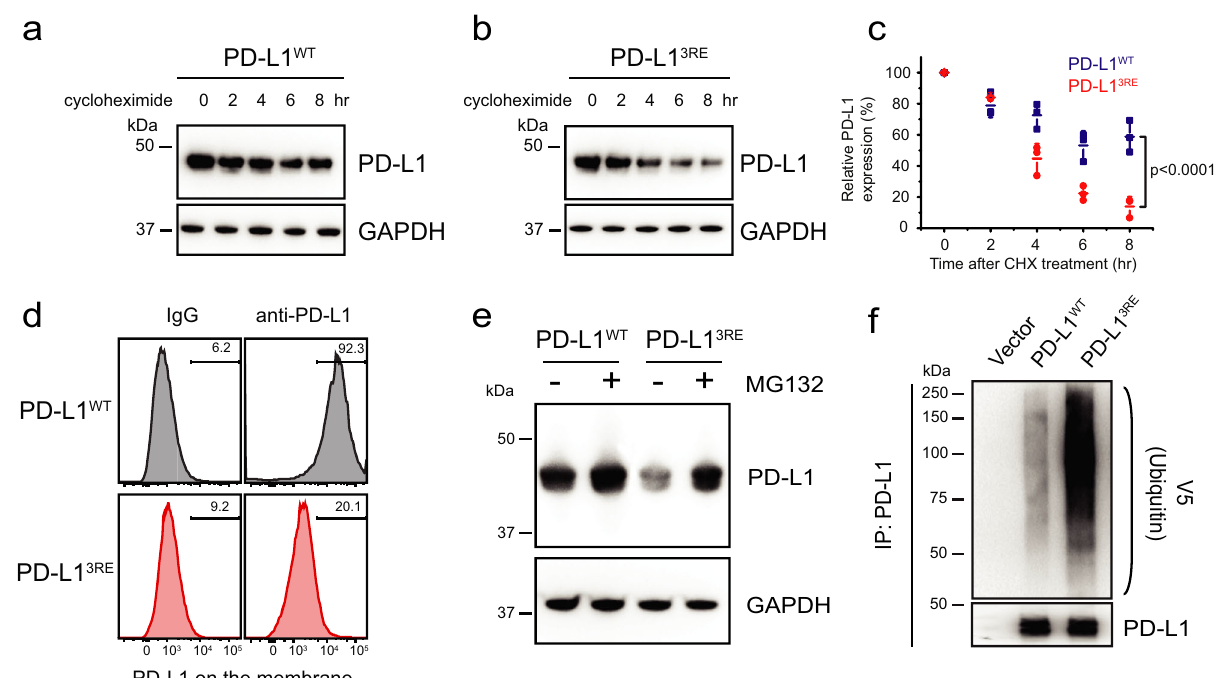
Fig. 4 The 3RE mutation reduces cellular PD-L1 protein levels. a – c Cellular levels of PD-L1 WT or PD-L1 3RE mutant. HEK293T cells expressing exogenous PD-L1 WT or PD-L1 3RE mutant were treated with 20 μ M cycloheximide (CHX) for 2, 4, 6, or 8 h. The PD-L1 level was analyzed by western blot ( a , b ). The intensities of the PD-L1 protein bands on the blots were quanti fi ed by ImageJ analysis, and the statistical data shown in ( c ) are the mean ± SD ( n = 3 independent experiments). P values by two-sided Student ’ s t-test were indicated. d Surface level of PD-L1 WT or PD-L1 3RE mutant in HEK293T cells determined by fl ow-cytometric analysis. e Cellular level of PD-L1 WT or PD-L1 3RE mutant in HEK293T cells treated with 10 μ M of the proteasome inhibitor MG132 for 4 h ( + MG132) or not (- MG132) determined by western blot. f Ubiquitination of PD-L1 WT or PD-L1 3RE mutant in HEK293T cells examined by V5 immunoblotting after IP with PD-L1 antibody, along with the control cells that did not express these proteins (vector). All data shown above are representative of three independent experiments. Source data are provided as a Source Data fi